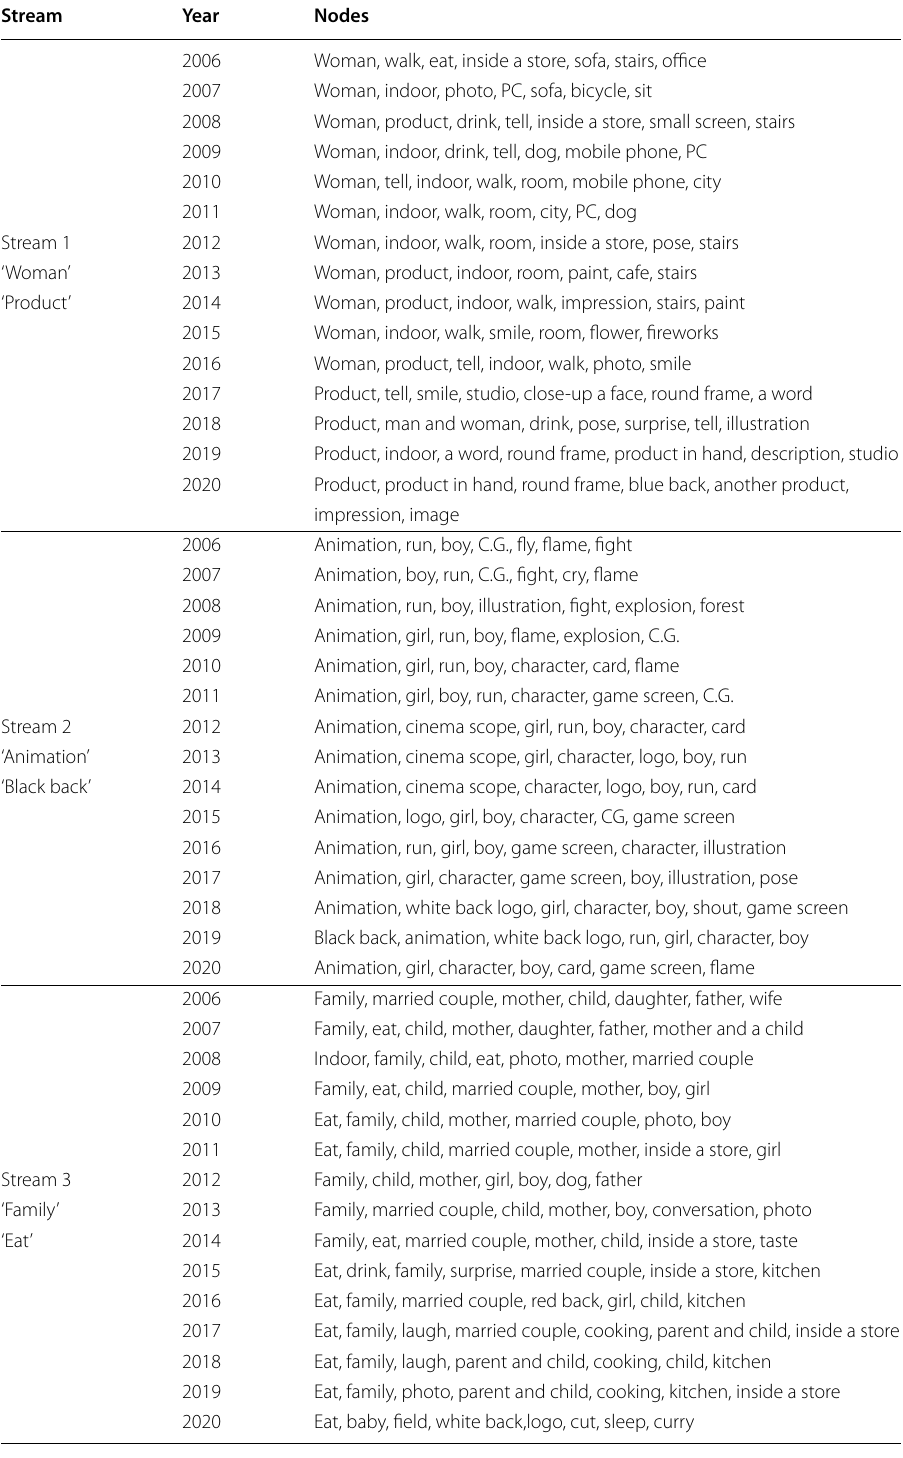
Table 5 Seven nodes with the largest strength in each community involved in Streams 1, 2 and 3